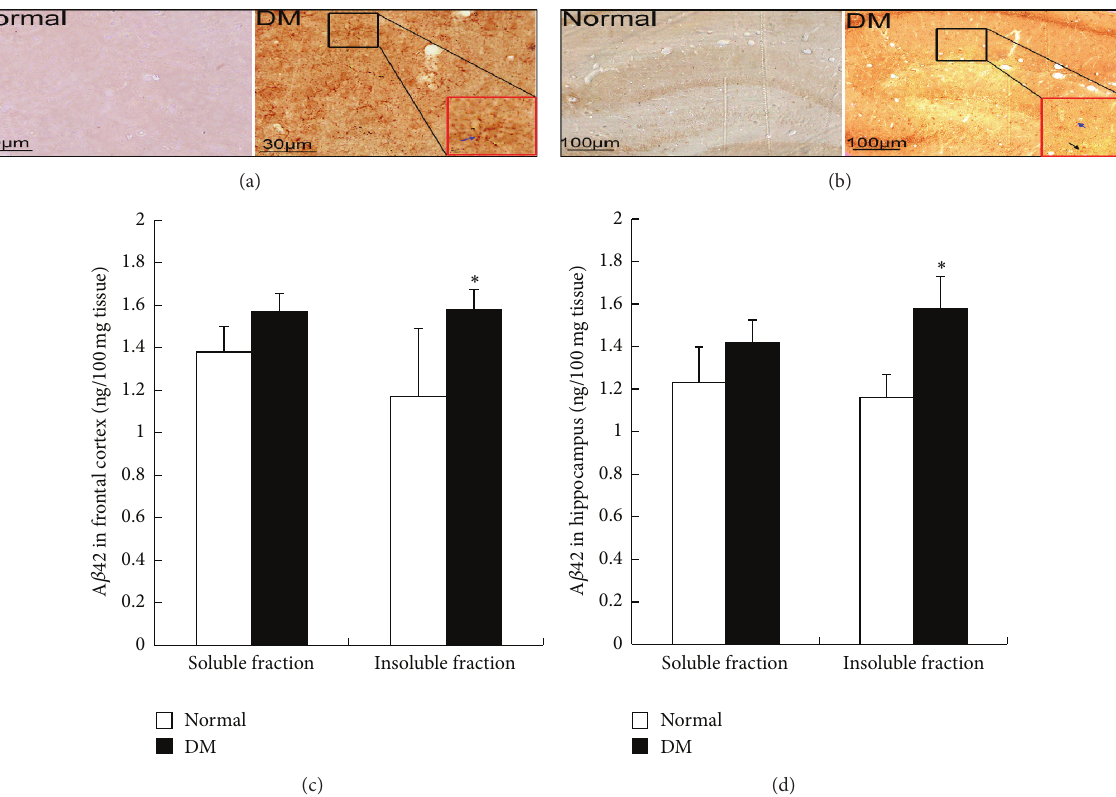
Figure 4: A 𝛽 42 deposition in rat hippocampus at 4 months after STZ injection. (a) Representative images of A 𝛽 42 immunoreaction in the frontal cortex: black square was magnified and shown in red square; blue arrow indicates the glial cells. (b) Representative images of A 𝛽 42 immunoreaction in the hippocampus: black square was magnified and shown in red square, blue arrow indicates the glial cells, and black arrow indicates the neuron. (c) A 𝛽 42 was quantified in soluble and insoluble fractions of the cortex by ELISA. (d) A 𝛽 42 was quantified in soluble and insoluble fractions of the hippocampus by ELISA. ∗ 𝑃 < 0.05 , significant difference compared with the age-matched control rats; 𝑛 = 6